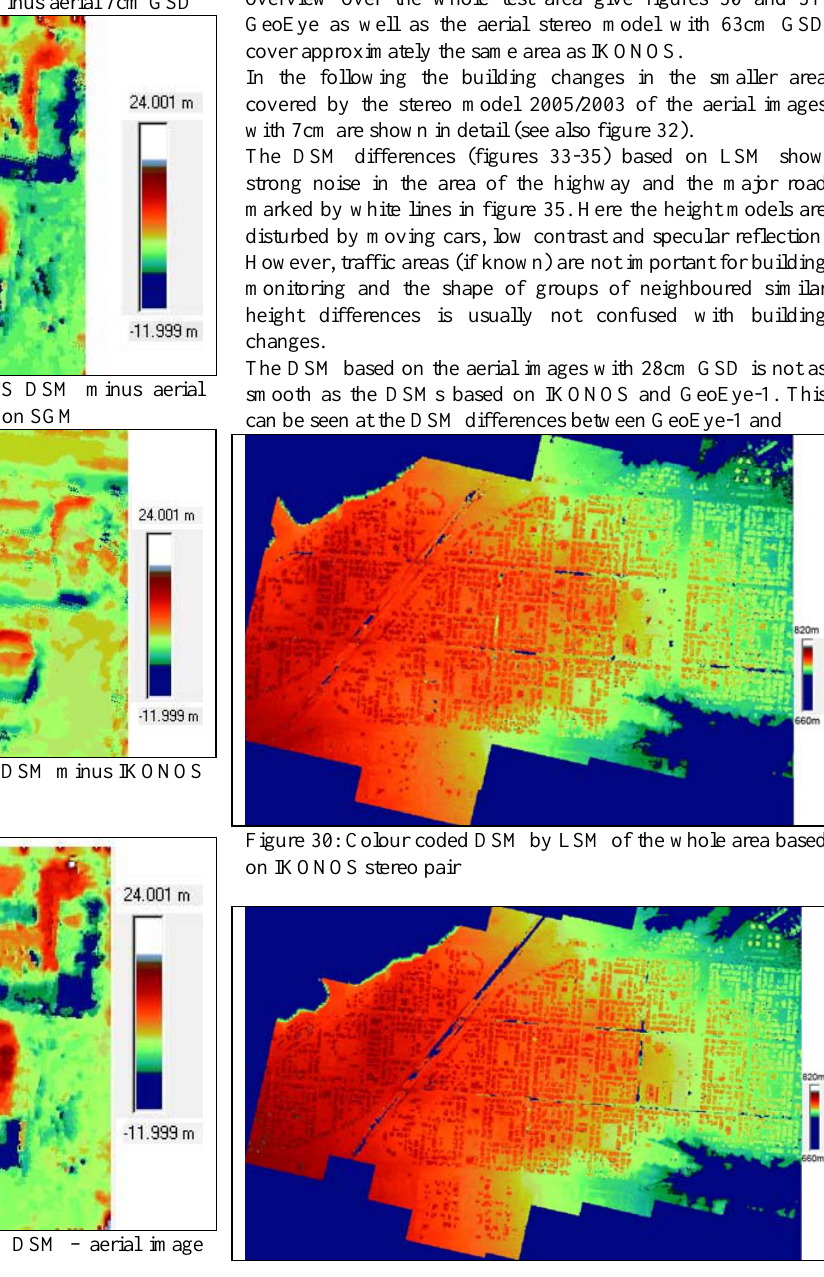
Figure 26: DSM differences – IKONOS minus aerial 7cm GSD